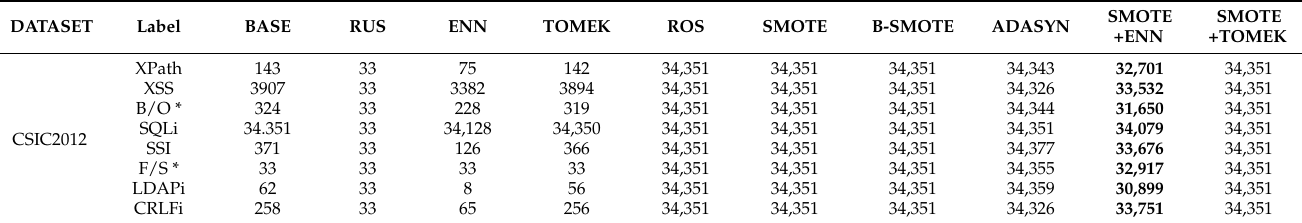
Table 7. Data distribution after sampling (dataset